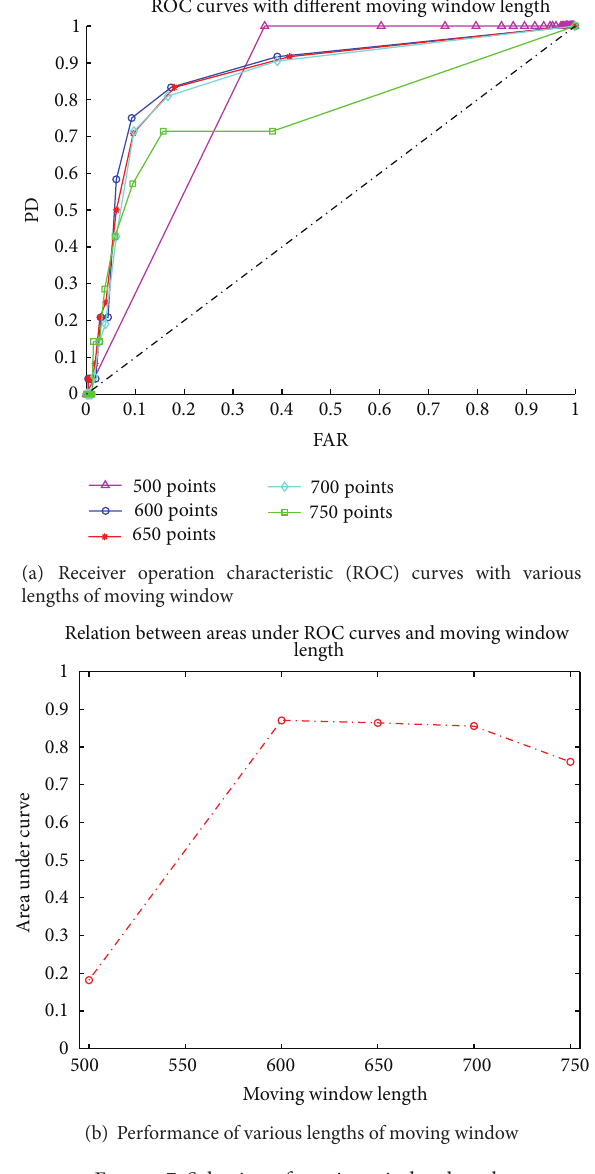
Figure 7: Selection of moving window length.